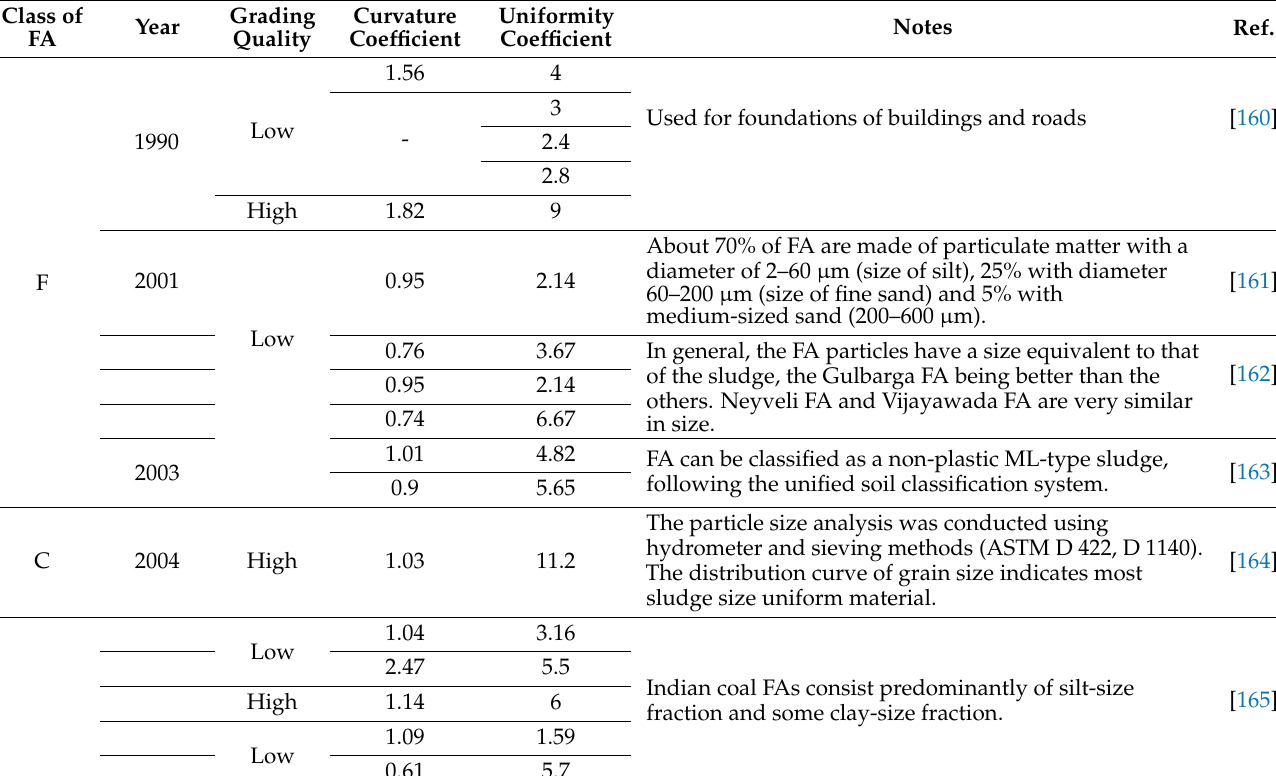
Figure 11. FA with gray to black color compared to the other identical SCMs [8]. Reprinted with permission from Elsevier [8]. Table 8. Review on grain size and grading quality of